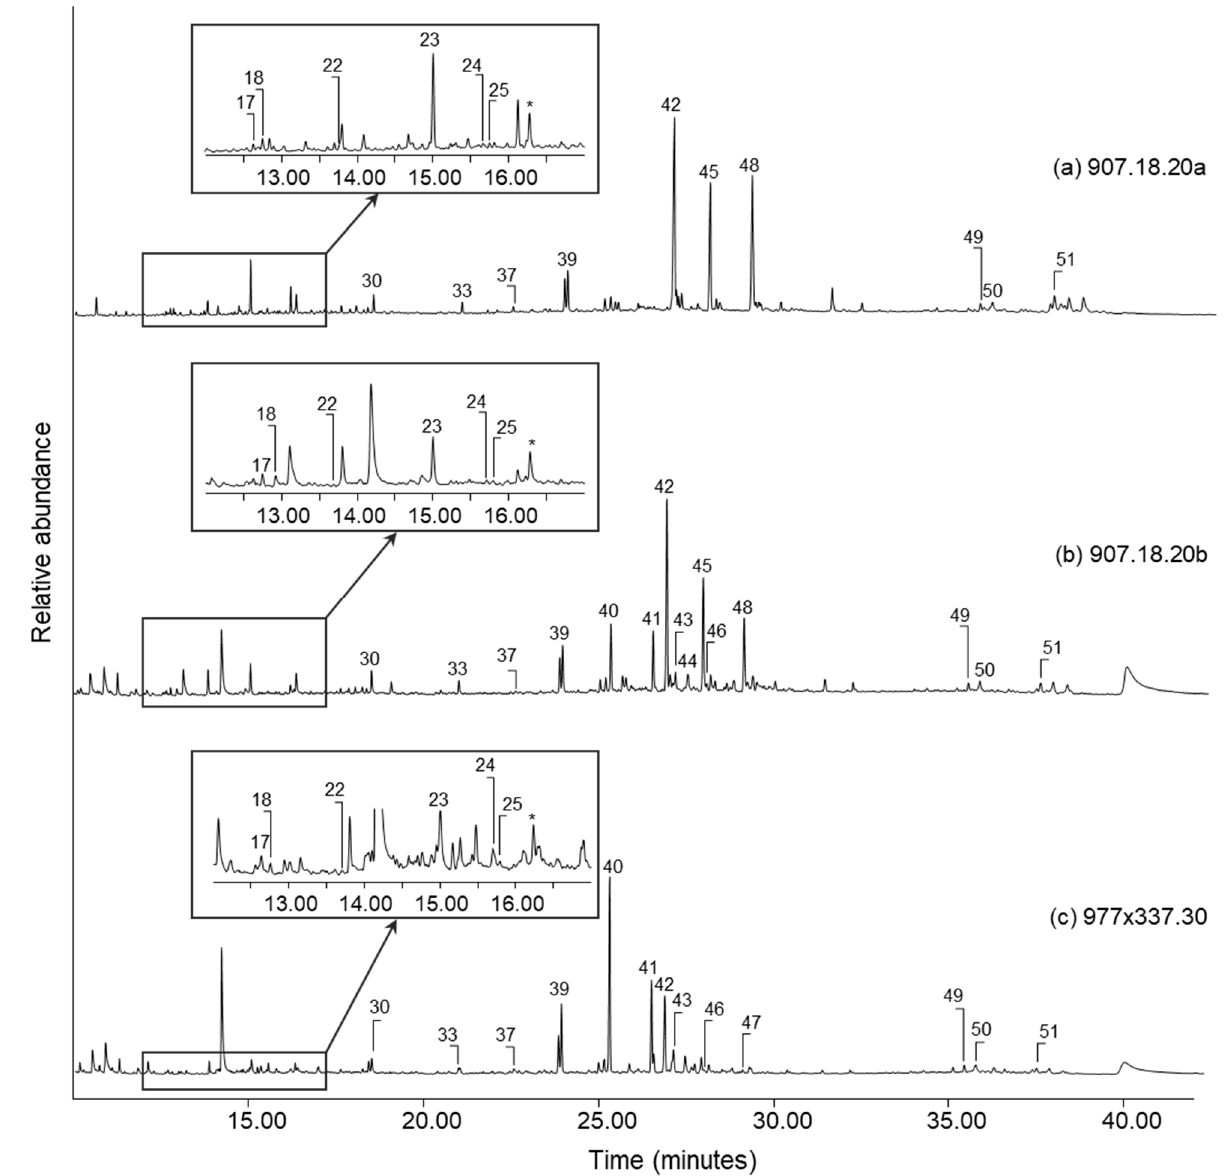
Figure 4. Total ion chromatograms from cloths with visible embalming resins (907.18.20a, 907.18.20b, and 977 × 337.30). A product derived from the pesticide pentachlorophenol is labelled with an asterisk (*). Peak labels correspond to compounds listed in Table 1.